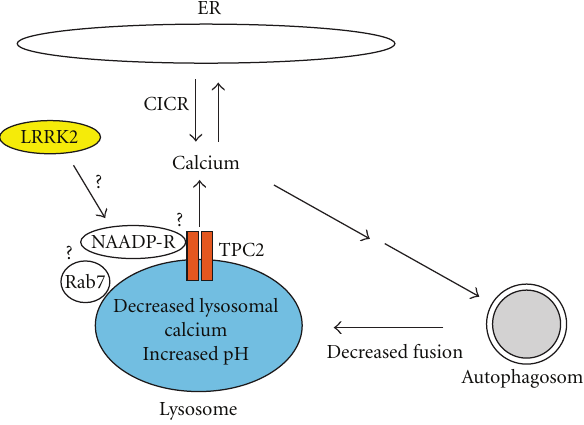
Figure 3: Diagram of proposed mechanism(s) by which LRRK2 regulates autophagy via modulation of NAADP-dependent calcium channels (NAADP-R) on lysosomes. LRRK2 localizes to lysosomes and regulates calcium release through two-pore channels (TPCs). Whether this is due to a direct interaction of LRRK2 with NAADP-R, an indirect interaction via rab7 or additional proteins, or whether it is mediated by a phosphorylation event remains to be determined. Calcium release from acidic organelles then causes calcium-induced calcium release (CICR) from the ER to amplify cytosolic calcium signals, which leads to the activation of a cascade to increase autophagosome numbers. Diminished luminal calcium will further cause a decrease in autophagosome-lysosome fusion, and increased pH may have additional e ff ects on eventually impairing lysosomal proteolysis, leading to the observed autophagic-lysosomal clearance phenotype.